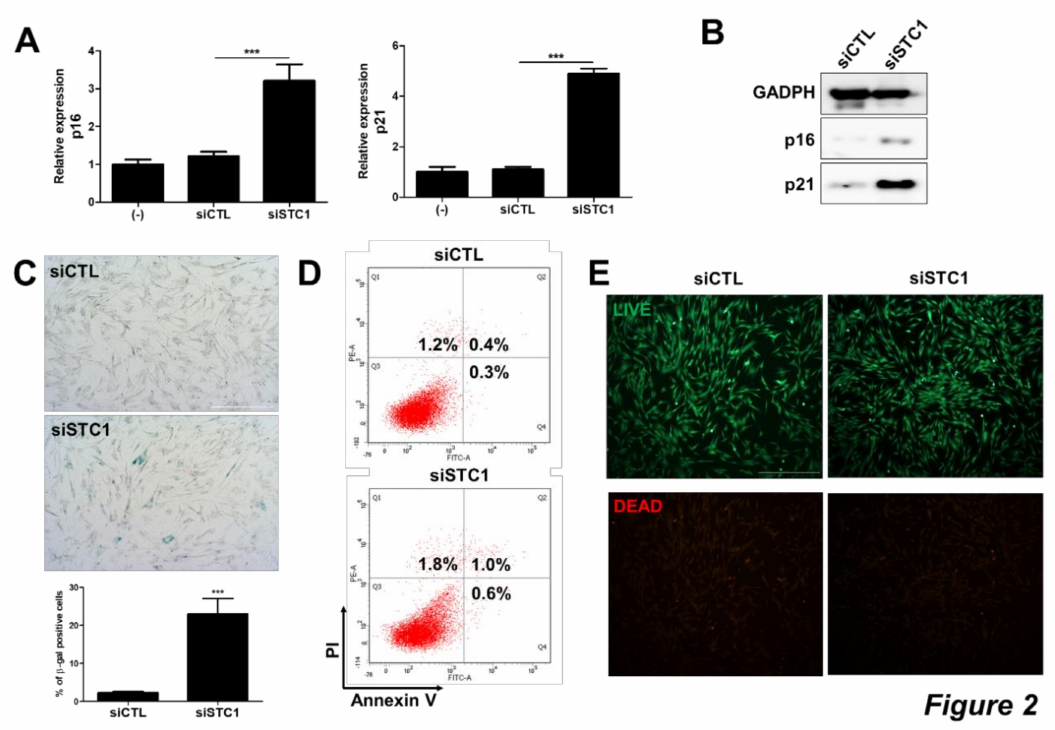
Figure 2. Induction of TMSC senescence by STC1 inhibition. After three days of siSTC transfection, the expressions of cyclin dependent kinase inhibitors in TMSCs were determined in mRNA level by qPCR ( A ) and protein level by immunoblotting ( B ). Cellular senescence was assessed by β -gal staining and the number of β -gal positive cells compared to control group was counted ( C ). Annexin V and PI were stained in untreated or siSTC-treated TMSCs and analyzed for apoptosis by flow cytometry ( D ). Cell viability was evaluated by Live / Dead staining ( E ). Results are three technical replicates of TMSC from one donor. Representative results from two di ff erent TMSCs with similar tendency were